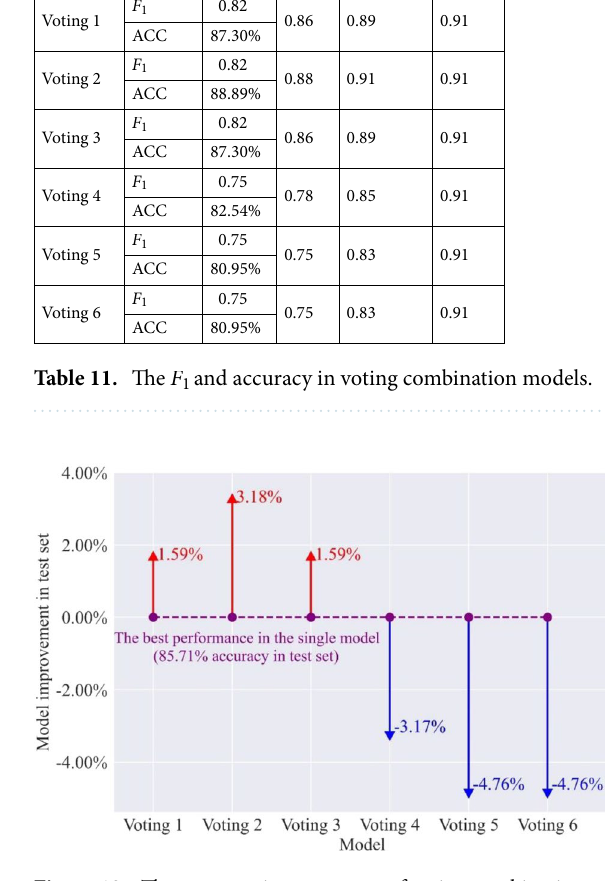
Figure 10. The accuracy improvement of voting combination models in the test set.